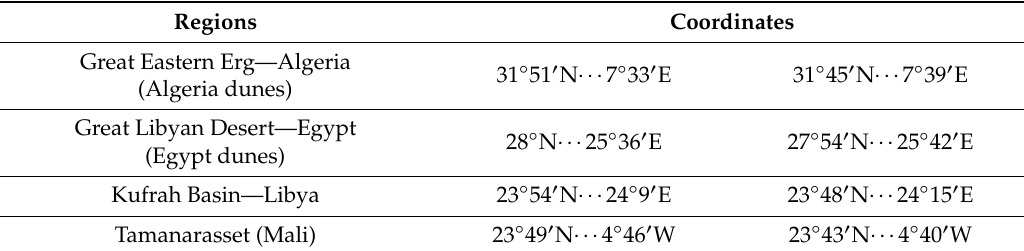
Figure 2. Plot of variations in Cyclone Global Navigation Satellite System (CYGNSS) reflectivity as a function of incidence angles: ( a ) Algeria dunes, ( b ) Kufrah area. Table 2. Coordinates of test areas used for CYGNSS data